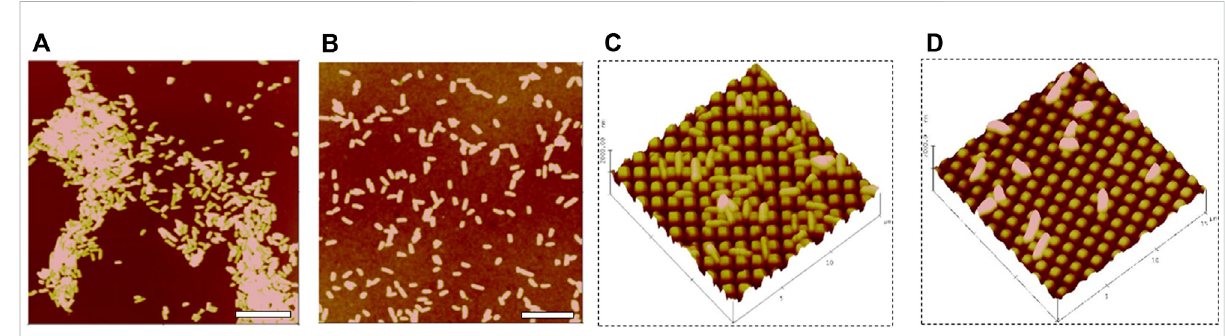
FIGURE 6 P. aeruginosa adhesion on smooth (A) , smooth with 15% SNAP (B) , side view bacterial adhesions on 700/700/300 nm patterned without SNAP (C) ,and700/700/300 nmpatternedwith10%SNAPPU fi lms (D) .Scalebar=10 µm.Side-view (C) and (D) scanarea:15×15 µ 2